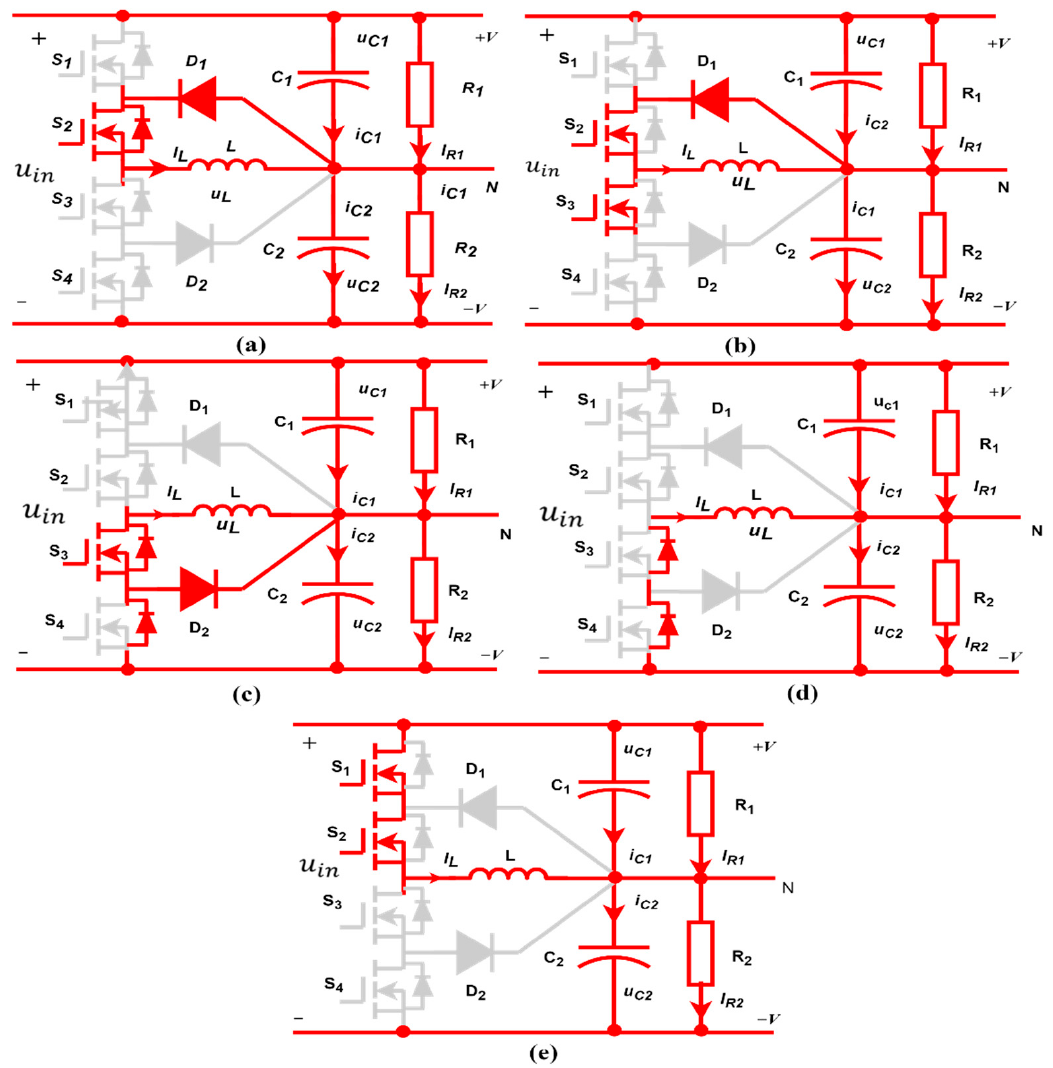
Figure 6. Three-level balancing converter equivalent circuit under state I. ( a ) Mode-I and VII. ( b ) Mode-II and VI. ( c ) Mode-III and V. ( d ) Mode-IV. ( e ) Mode-VIII. The corresponding voltages are displayed in Figure